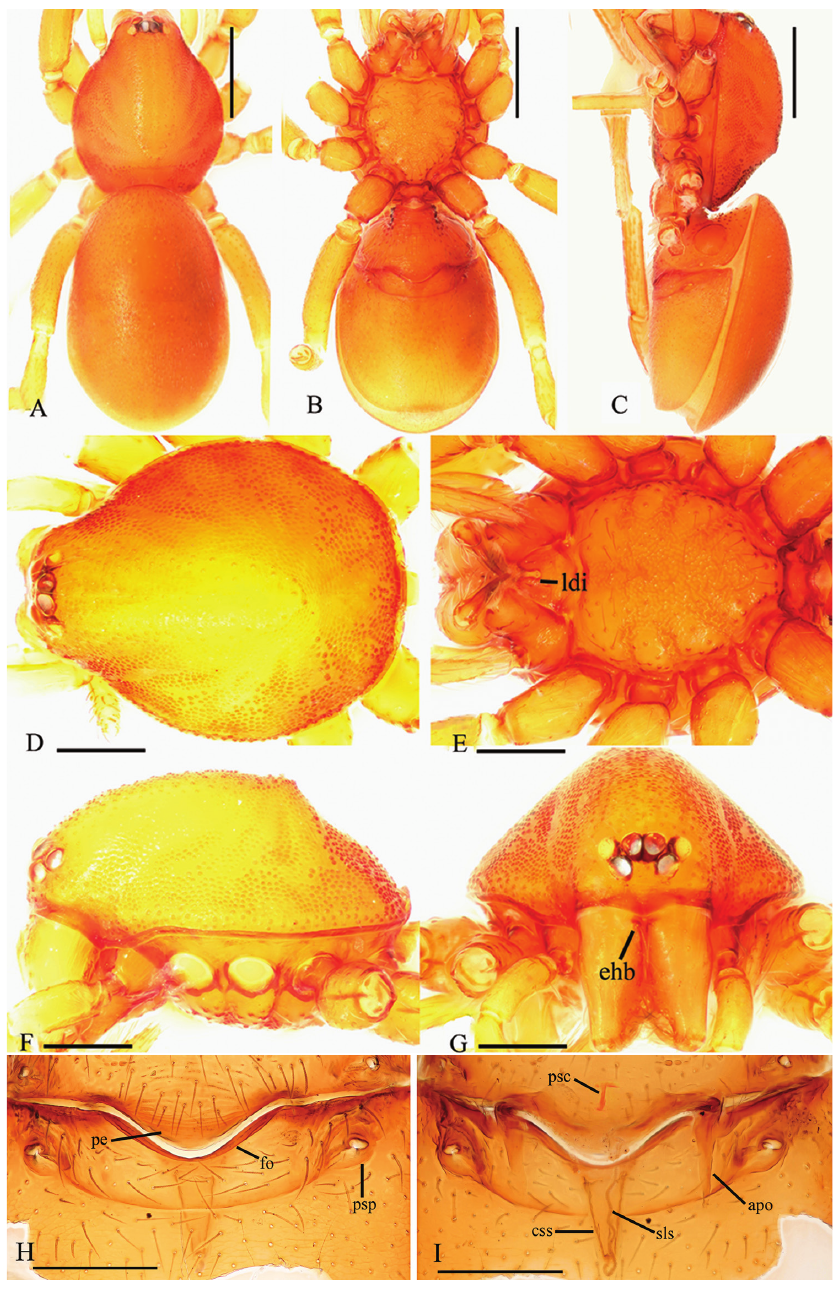
Figure 5. Trilacuna simianshan sp. n., female. A, B, C habitus, dorsal, ventral and lateral views D, E, F, G prosoma, dorsal, ventral, lateral and anterior views H, I genitalia, ventral and dorsal views. Ab- breviations: apo = apodemes; css = cone-shaped structure; ehb = elevated hair base; fo = fold; ldi = labium deep incision; pe = posterior extension; psc = paddle-like sclerite; psp = posterior spiracles; sls = slender line-like structure. Scale bars: 0.2 mm ( A–C ); 0.1 mm ( D–I